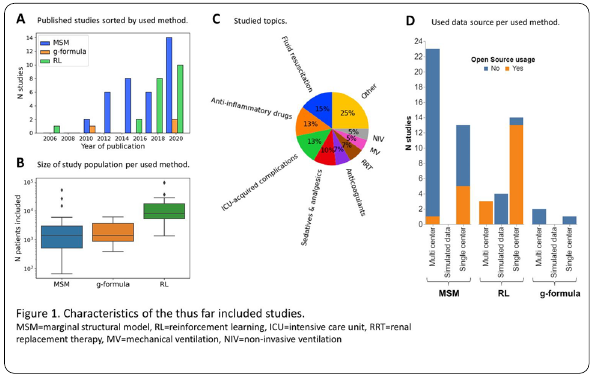
Table 2. The first four rules for A. baumanii sorted by decreasing order in respect of confidence LHS RHS Measures Gender Type